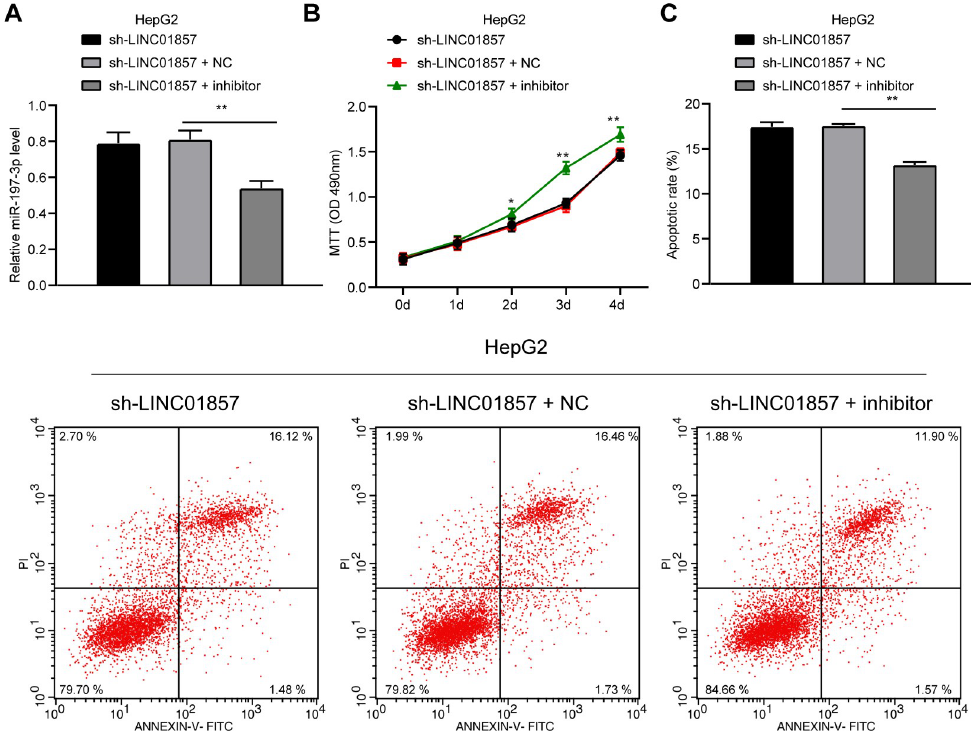
Fig 4. miR-197-3p knockdown attenuates the effect of silenced LINC01857 on reducing HCC cell proliferation and improving apoptosis. miR-197-3p-IN was transfected into HepG2 cells with silenced LINC01857, with IN-NC as NC. A, miR-197-3p inhibitor transfection efficiency detected by RT-qPCR. B, cell proliferation measured by MTT. C, apoptosis examined via flow cytometry. Three independent repeated tests were conducted. The results were presented as mean ± standard deviation. One-way ANOVA was employed to analyze the data in panel A. Two-way ANOVA was employed to analyze the data in panels B and C. Tukey’s multiple comparisons test was applied for the post hoc test. �� p <